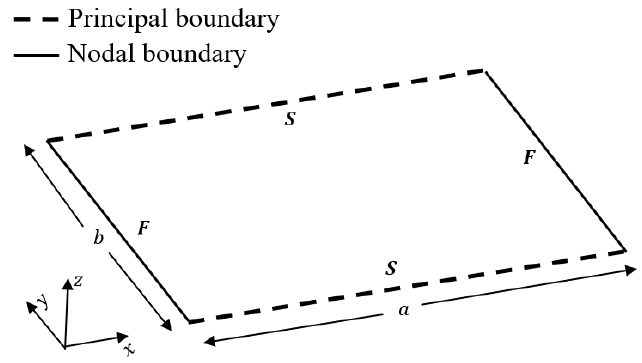
Figure 10. Boundary conditions applied on four edges of a plate.